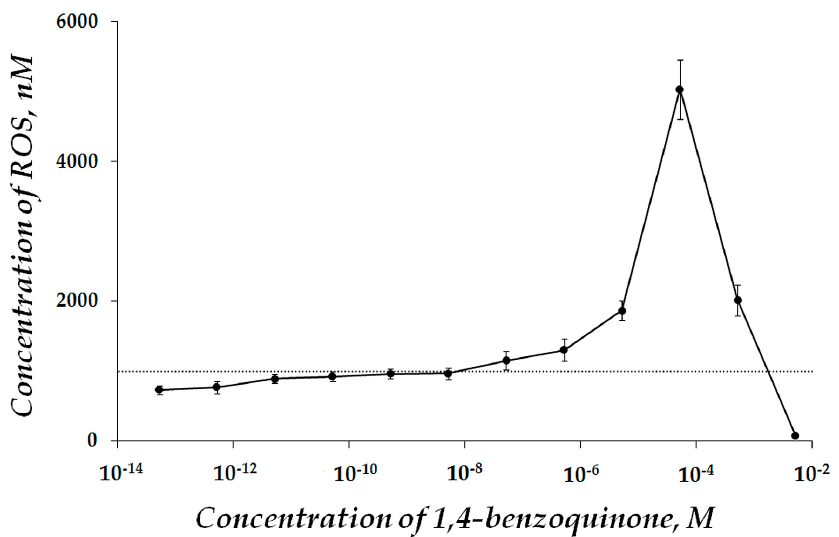
Figure 5. ROS content at different concentrations of 1,4-benzoquinone in water solutions. ROS concentration in control (distilled water) was 1000 nM.